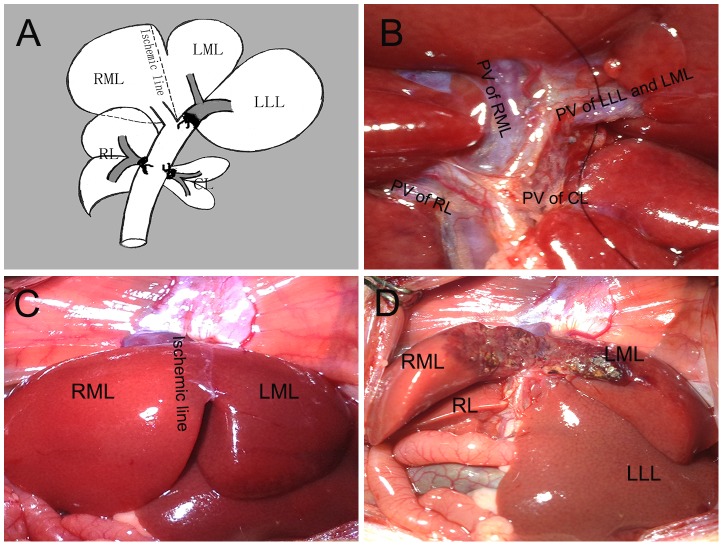
Illustrations of surgical procedure of PVL+ISS.(A) Schematic anatomy of liver lobes and portal veins: right median lobe (RML), left median lobe (LML), left lateral lobe (LLL), right lobe (RL), caudate lobe (CL). The silk knots represent the ligated lobes. (B) Portal veins (PV) of rats in surgery. (C) Ischemic line emerged to the right of the falciform ligament when the left branch of the portal vein was ligated. (D) The median lobe was in situ split along the ischemic line.